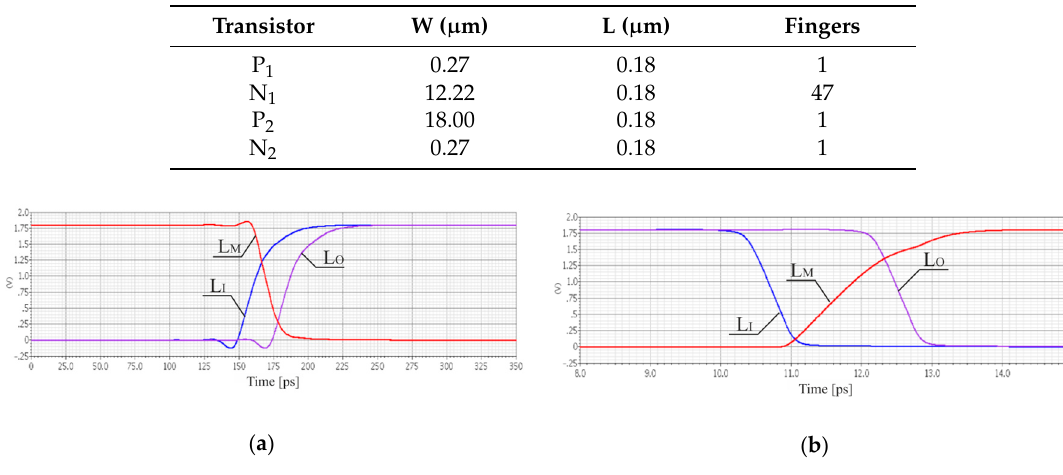
Figure 25. Simulation results for 180 nm CMOS process: signals at input (L I ), in the middle (L M ), and at output (L O ) of asymmetric pair of inverters for rising active edge ( a ); signals at input (L I ), in the middle (L M ), and at output (L O ) of asymmetric pair of inverters for falling inactive edge ( b ).